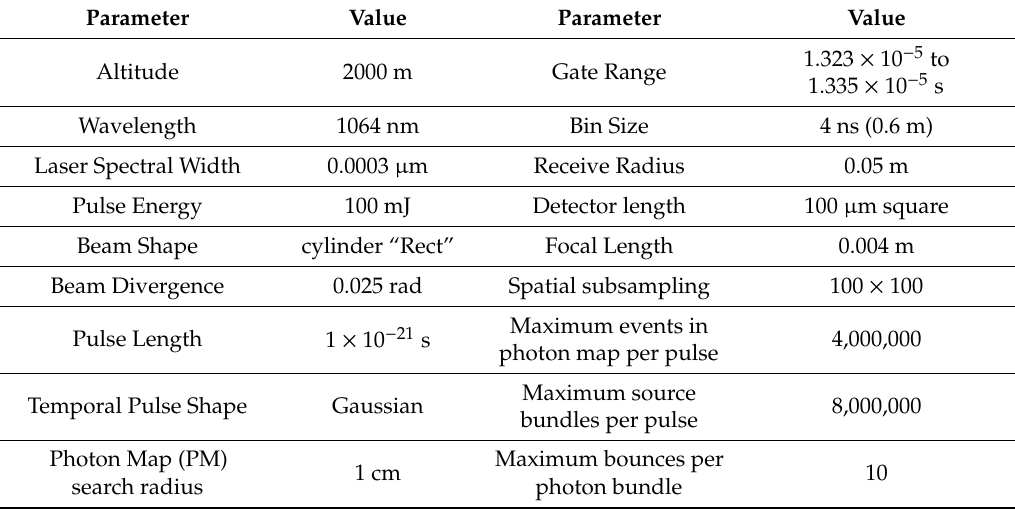
Table 1. Digital Imaging and Remote Sensing Image Generation (DIRSIG) lidar settings for radiation transfer model inter-comparison (RAMI-IV)